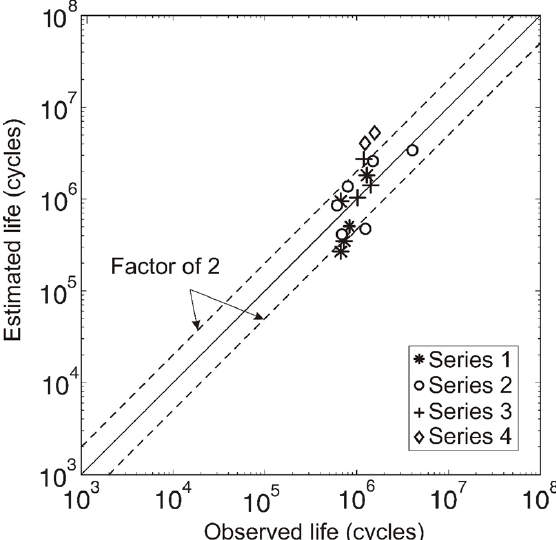
Figure 5: Observed and estimated fatigue lives for fretting fatigue tests conducted by Nowell